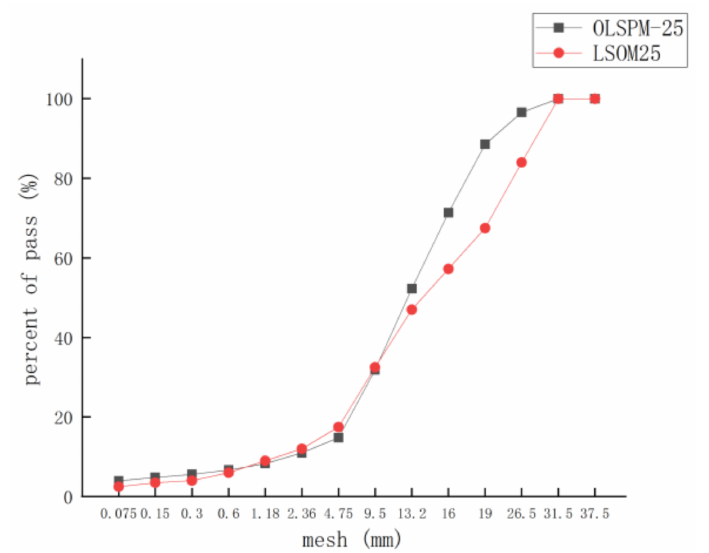
Figure 7. Under the same porosity, the gradation curves of OLSPM-25 and